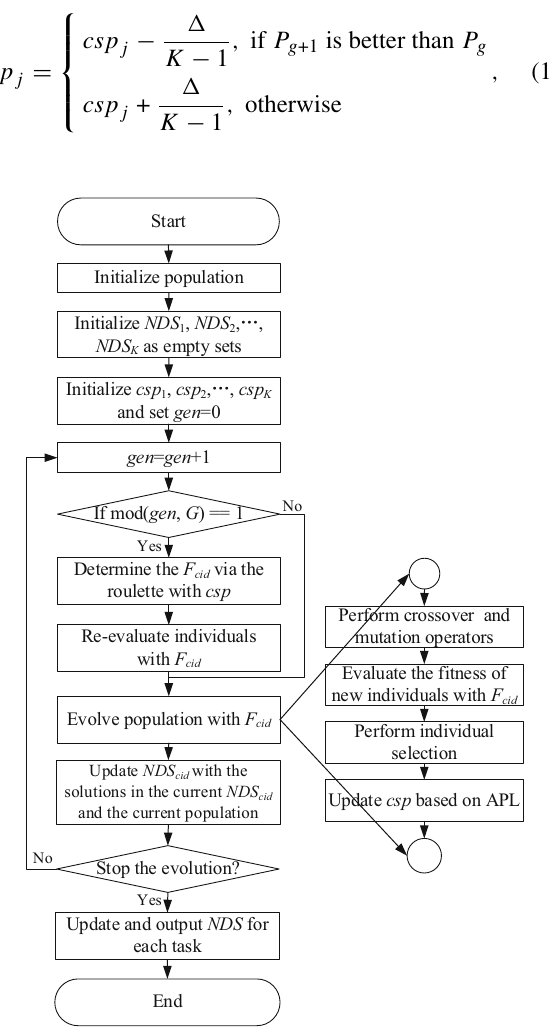
Fig. 2 The flowchart of the complete